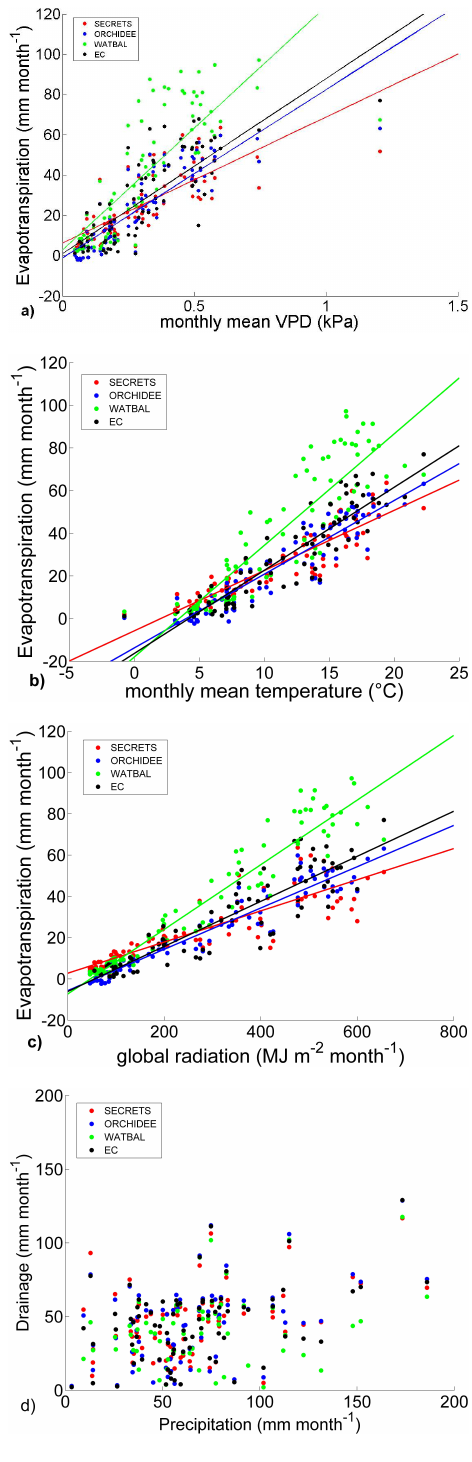
Fig. 7. Linear regression lines for three main drivers of ET on monthly scale for the four different approaches (SECRETS, OR- CHIDEE, WATBAL, eddy covariance [EC]) examined in this study. Total global radiation (a) , mean annual temperature (b) and mean VPD (c) . The lower right panel shows (d) the relation between monthly drainage (ordinate) and precipitation